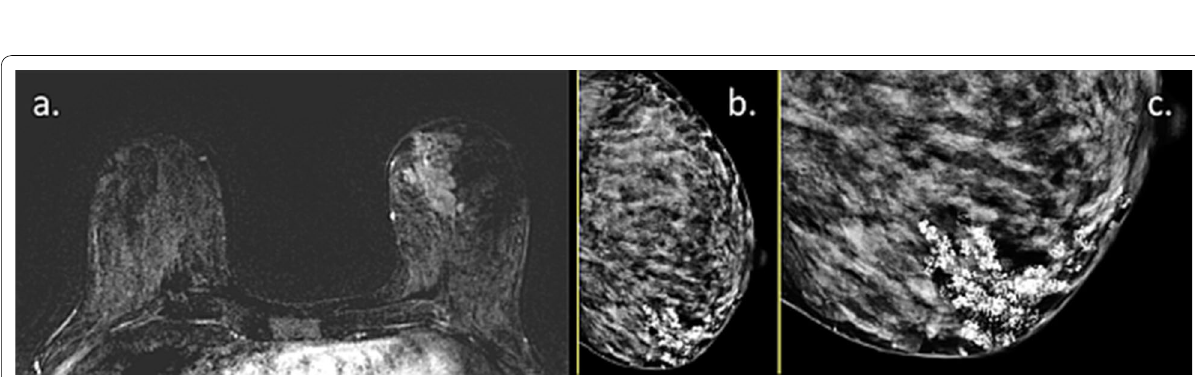
Fig. 16 MRI of post‑partum DCIS. Images of a 33‑year‑old PABC patient (lactating cessation a week prior to the MRI) diagnosed with left breast DCIS are presented. The patient palpate a lump in the left breast during the third trimester of pregnancy and underwent breast US (not presented) which depicted a benign appearing 9 mm oval mass. Upon follow‑up 3 months later, post‑partum, focal US depicted irregular mass with calcifications. Further diagnostic workup included US‑guided biopsy, mammography which revealed extremely dense breast with segmental distribution of suspicious micro‑calcifications in the inner‑lower quadrant ( b and zoomed image c ), as well as breast MRI ( a ) which showed the characteristic NME of DCIS along 42 mm, in agreement with the mammographic findings, on top of the moderate background enhancement (BPE